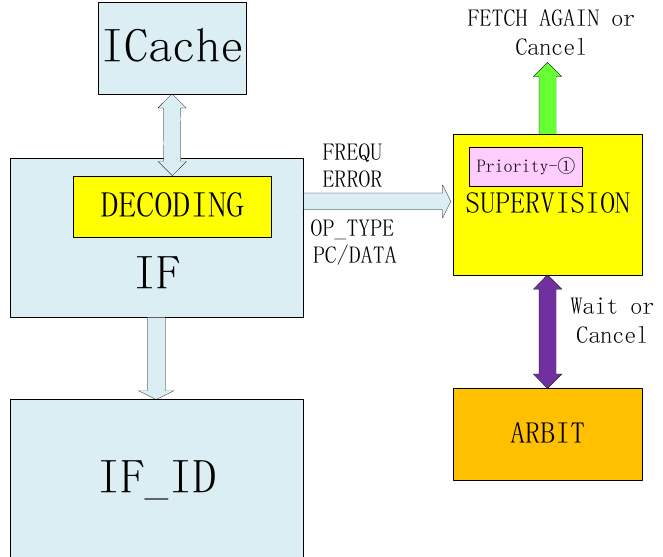
Figure 9. Fetching rollback process. The fetching refers to fetching data from the ICache. After decoding, if there is no exception, the data will enter the next timing logic. After the exception occurs, the relevant data will be sent to the SUPERVISION module. The SUPERVISION module performs re-fetching or cancels fetching according to the processing given by the ARBIT module.